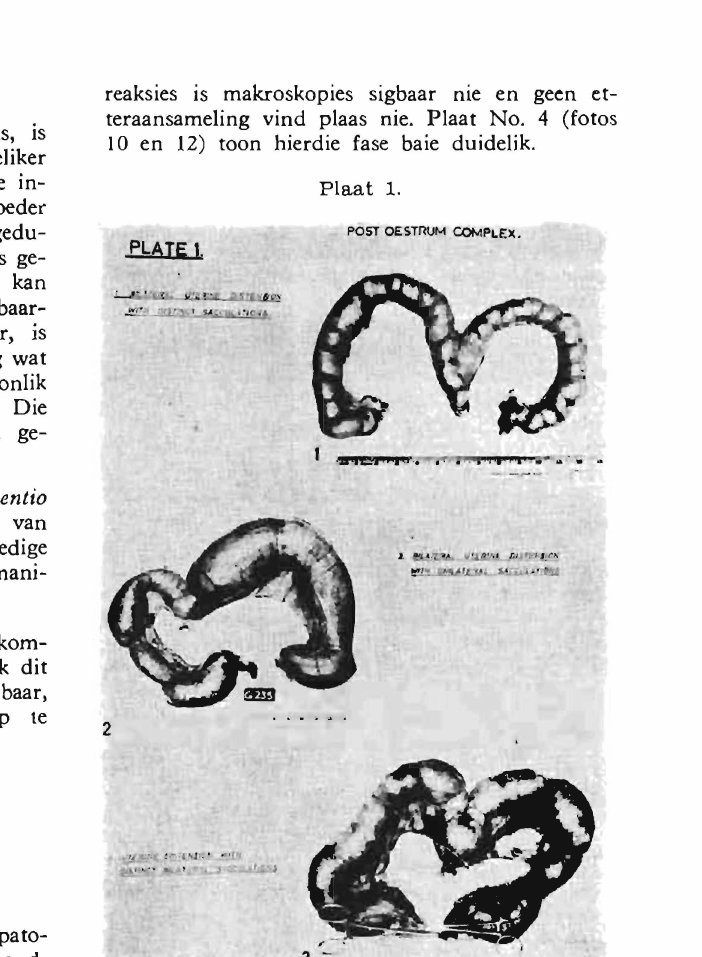
met daaropvolgende in dringing van bakteriese organismes, wat dan aan leiding gee tot die uitgesproke piometra, oftewel die gevalle met massale etteraansameling. Dus is die patologiese afwykings wat die geval mag ver toon afhanklik van die stadium van ontwikkeling waarop die geval ondersoek word. Die vroee gevalle, oftewel die potensiele pio